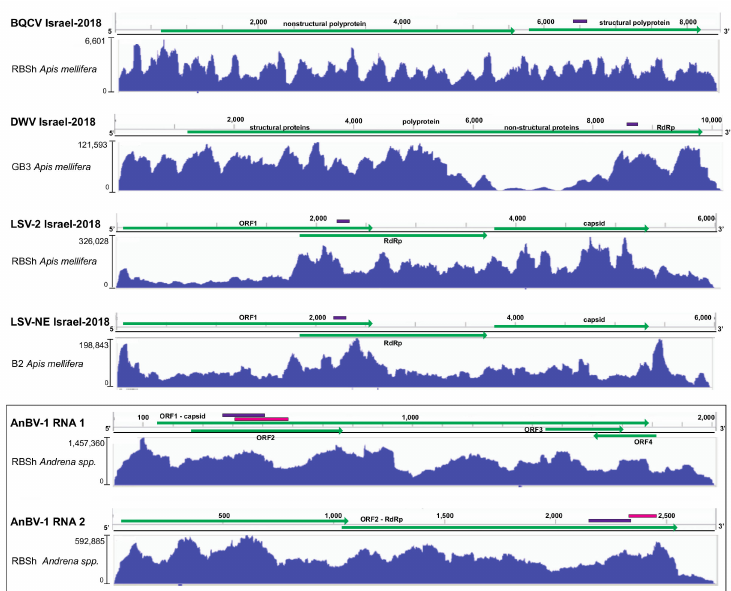
Figure 2. Sequence coverage of virus genome variants characterized by high-throughput sequencing and virus-specific qPCR. Reads in the sequence library with the highest number of reads were aligned to the consensus genome variants identified in this study including BQCV Israel-2018 (MW397638), DWV Israel-2018 (MW397639), LSV-2 Israel-2018 (MW397637), and LSV-NE Israel-2018 (MW397636), and to both genome segments of Andrena-associated bee virus-1 (AnBV-1), the novel bicistronic (+) ssRNA virus identified in this study (MW397640, MW397640). Vertical and horizontal Scheme 3.2.2. Deformed wing